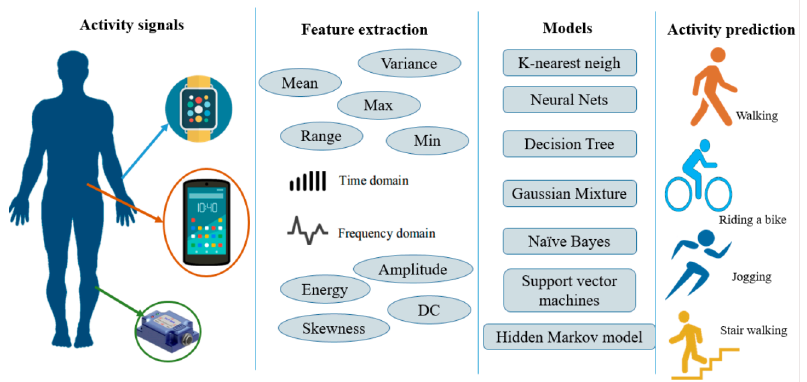
Figure 1. Conventional PR for a sensor-based